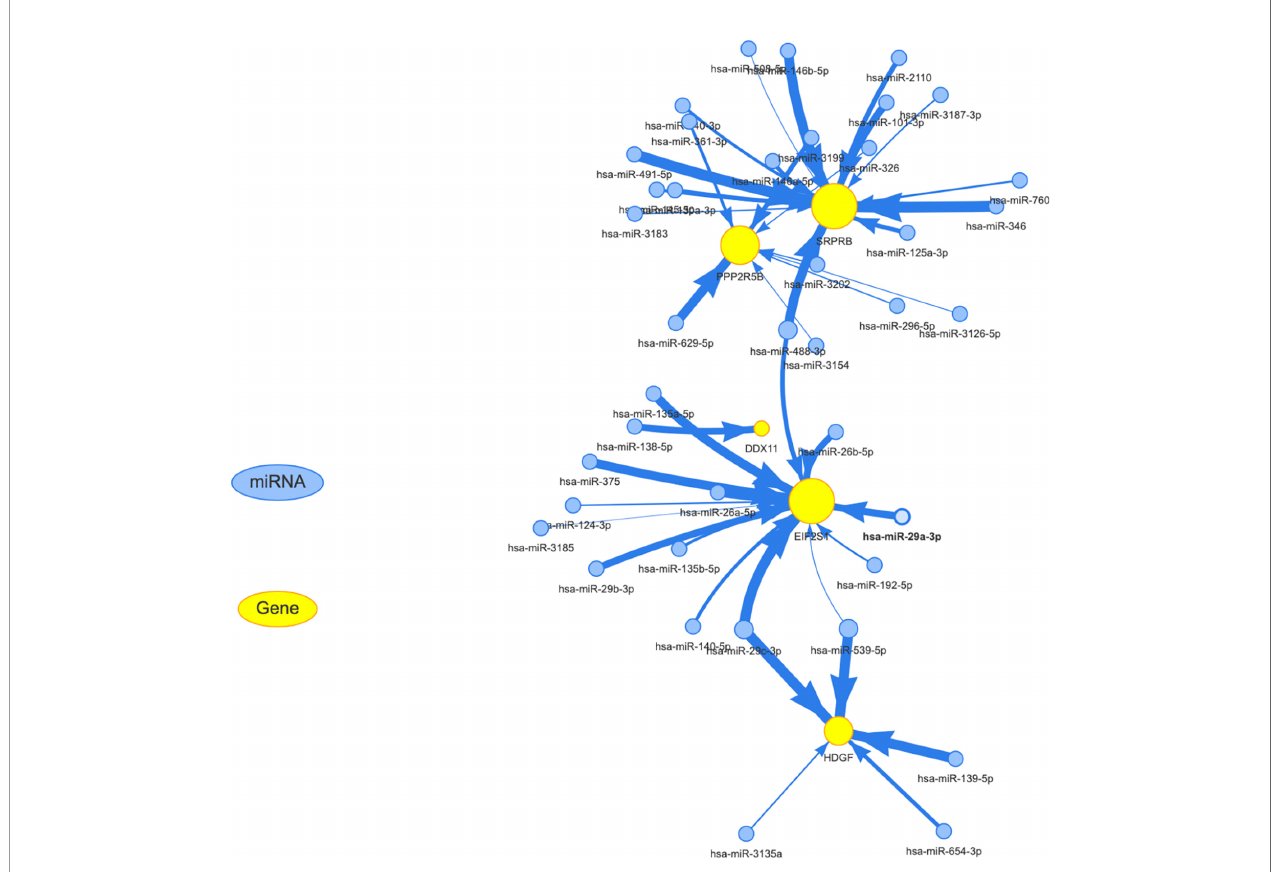
FIGURE 9 | Establishment of miRNA-mRNA regulatory network. The yellow and blue circles represent the target gene and miRNA, respectively. The arrows represent regulatory